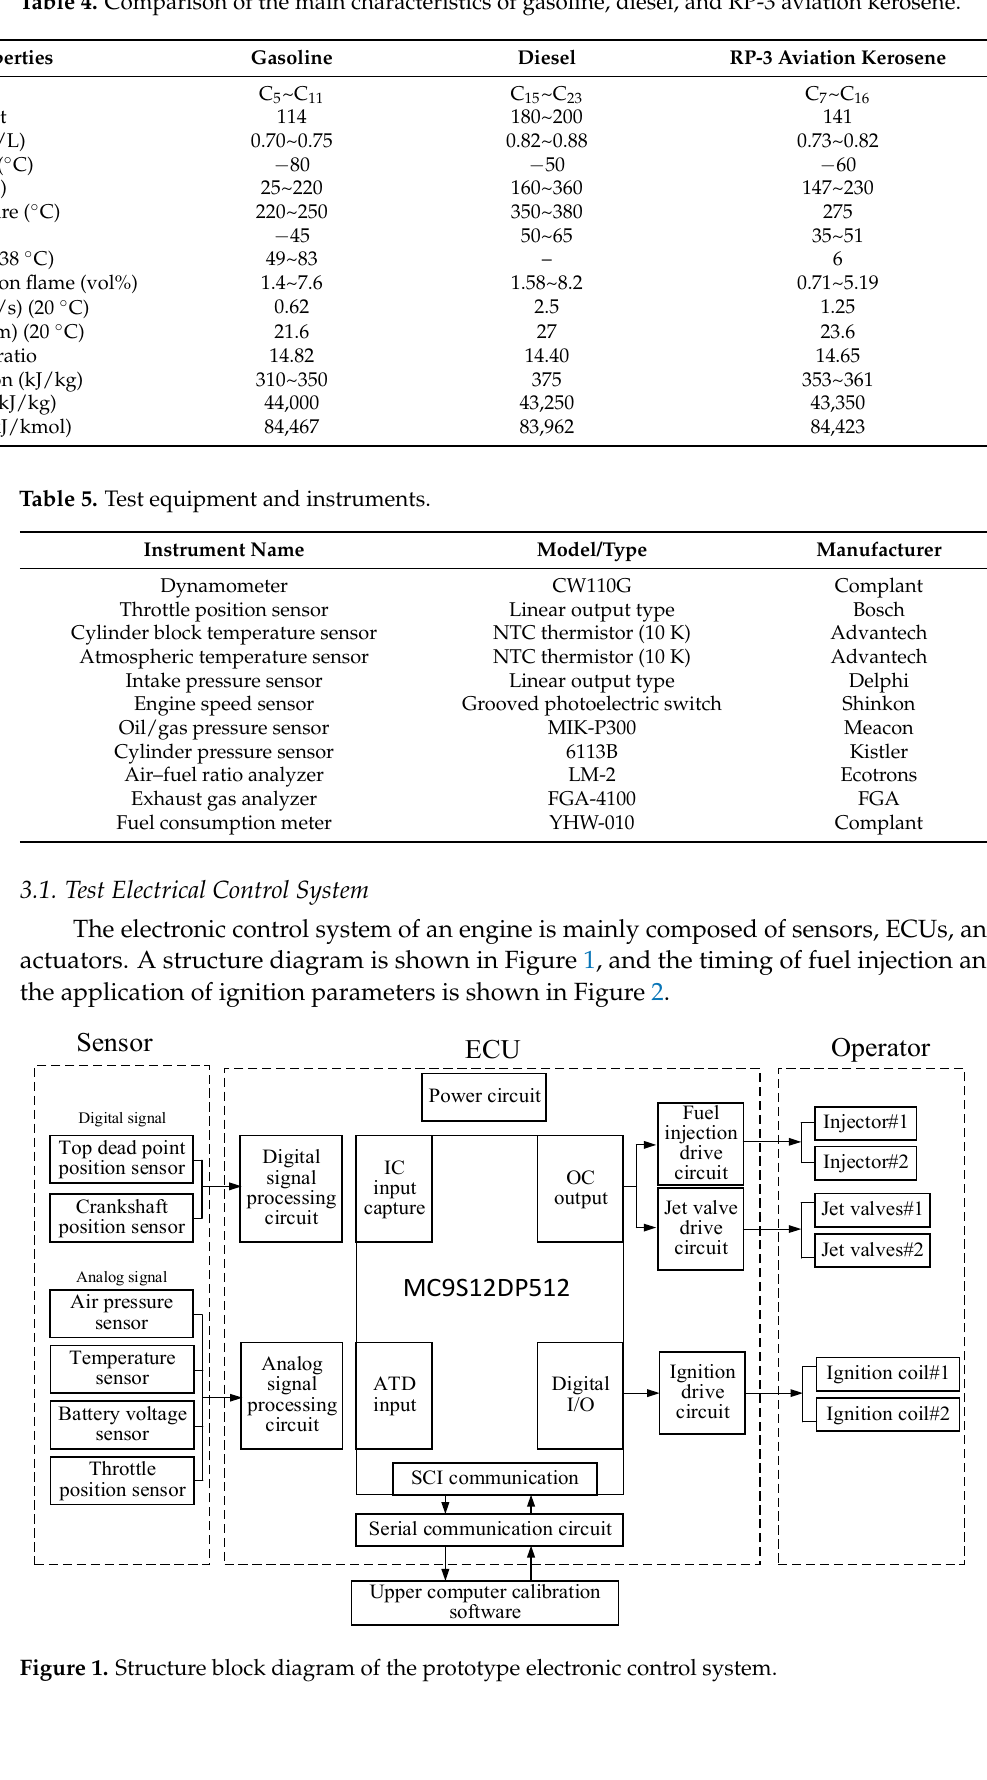
Table 4. Comparison of the main characteristics of gasoline, diesel, and RP-3 aviation kerosene.